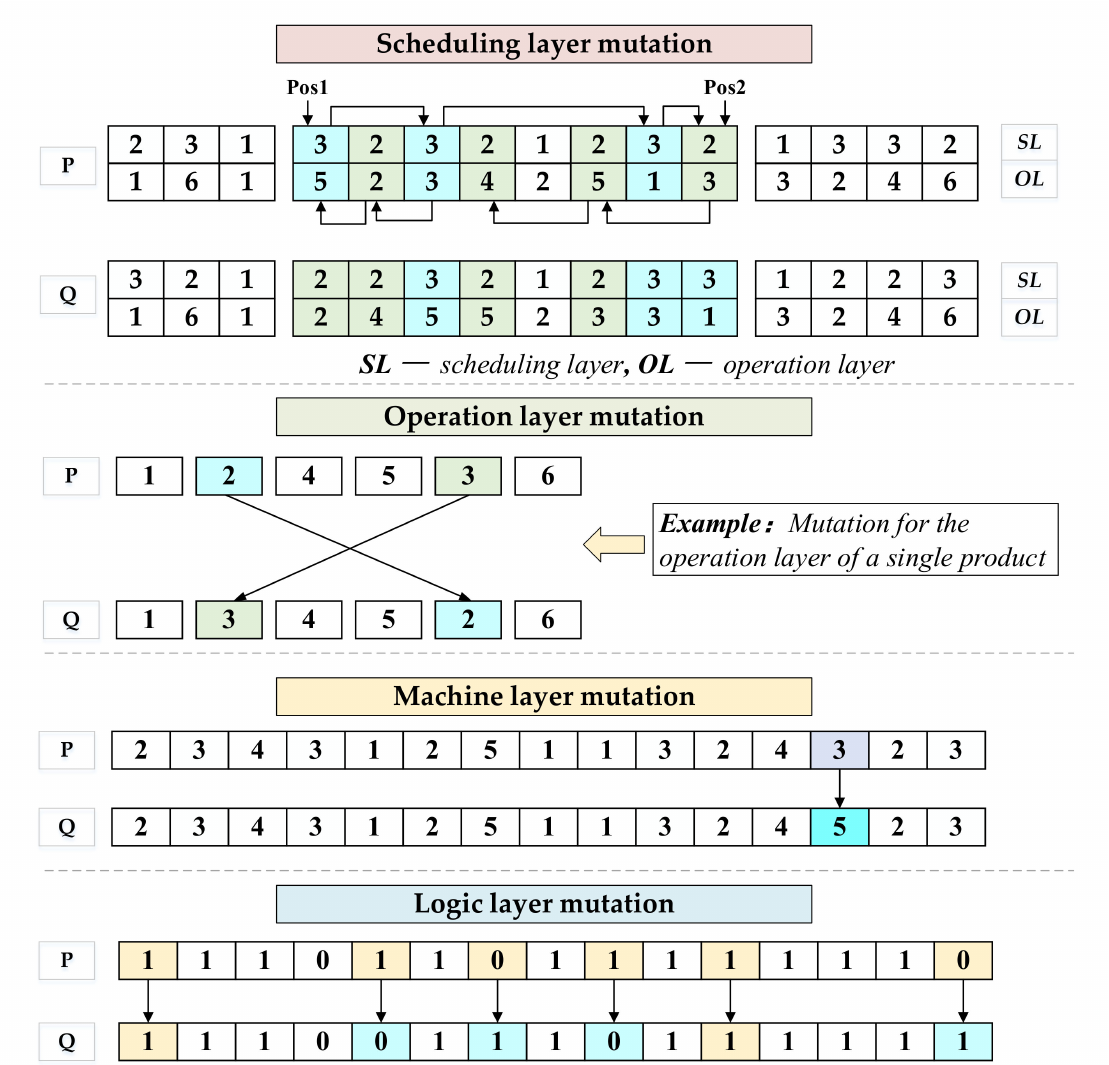
Figure 8. Illustration of mutation operators for di ff erent coding